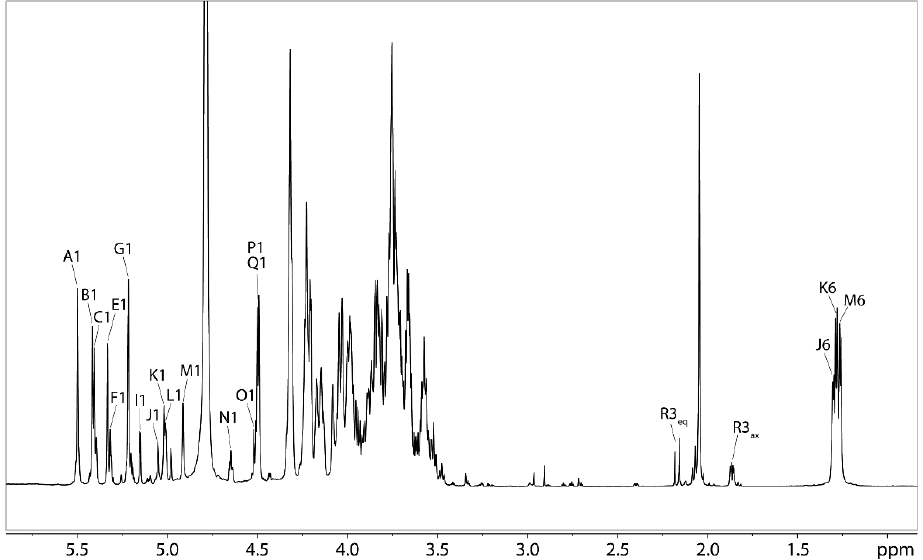
Figure 7. The 1D 1 H-NMR spectrum obtained from the LPS of Lcr after lipid A removal. The anomeric signals and other distinct signals are labeled. For labels of the other protons/carbons, see Figure